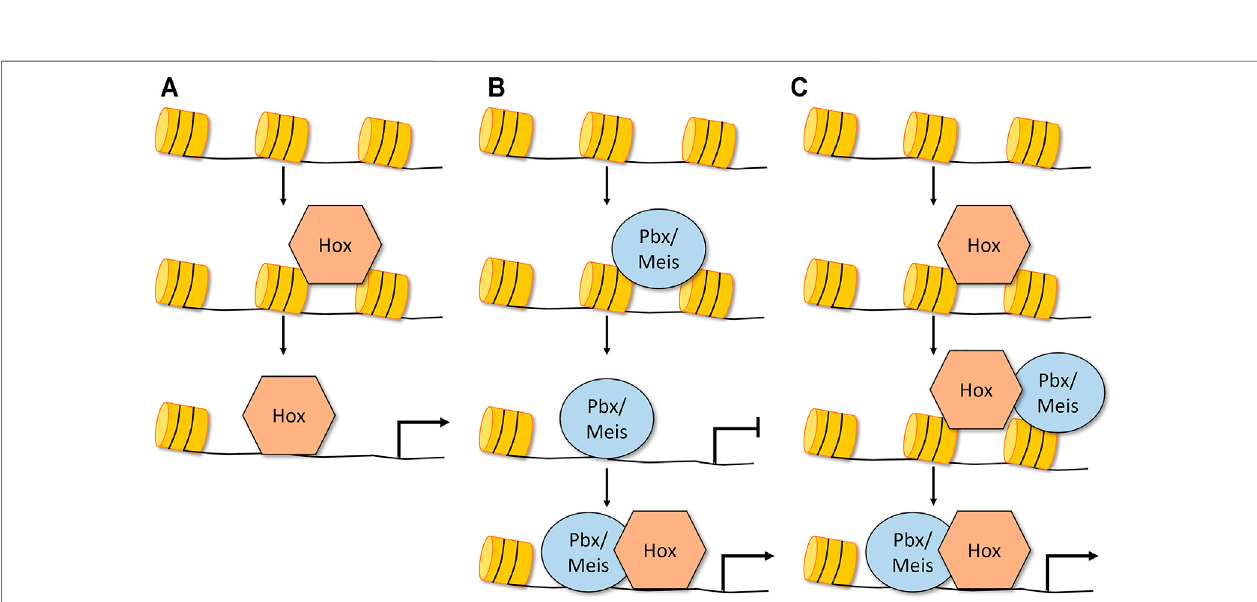
FIGURE2| Mechanisms bywhichHoxfactors couldexhibitpioneer-likeactivity and alterchromatinaccessibility. (A) Dfd andAbd-B Hoxfactorsalonecanbindto inaccessible chromatin and increase the chromatin accessibility of its targets without co-factor expression (Porcelli et al., 2019). (B) Pbx/Meis in vertebrates have been shown to bind inaccessible chromatin and promote chromatin opening. In this model, the Hox factor gains access to accessible DNA, forms a complex with Pbx/Meis, and this larger TF complex is required for accurate target regulation (Sagerstrom, 2004; Choe et al., 2014; Mariani et al., 2021). (C) Another potential model is that Hox TFs, a subset ofwhich are capable of binding inaccessible DNA, recruit Exd/Pbx and Hth/Meis and together these complexespromote chromatin opening (Porcelli et al., 2019). Note that in each of these models, the role of the Hox factor in chromatin opening has not yet been con fi rmed.